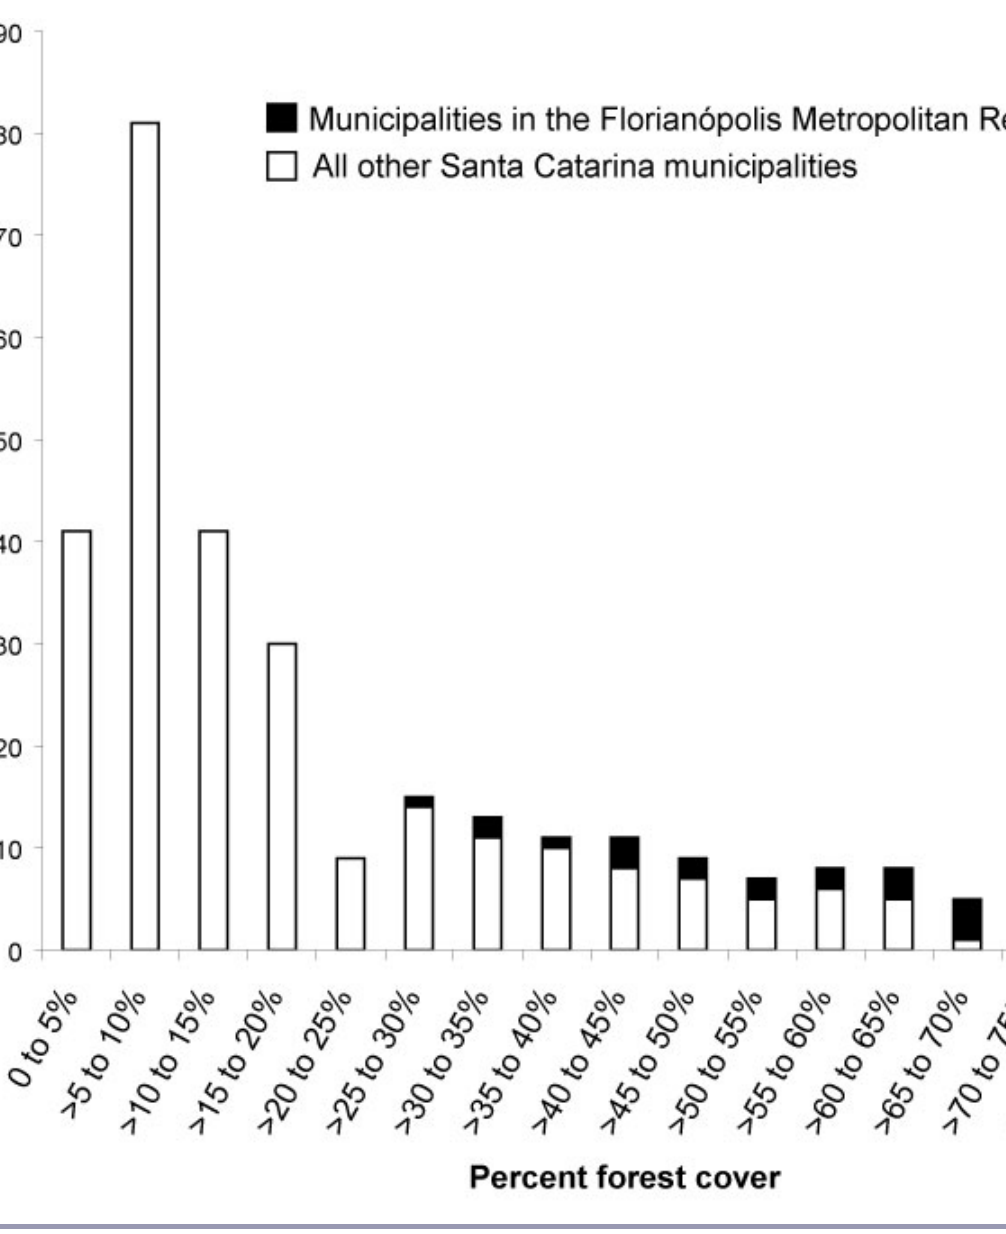
Fig. 2. Percent forest cover in the 293 municipalities of Santa Catarina, Brazil, 2005. Source: Data reported by Fundação SOS Mata Atlântica and Instituto Nacional de Pesquisas Espaciais (2006) based on the interpretation of satellite